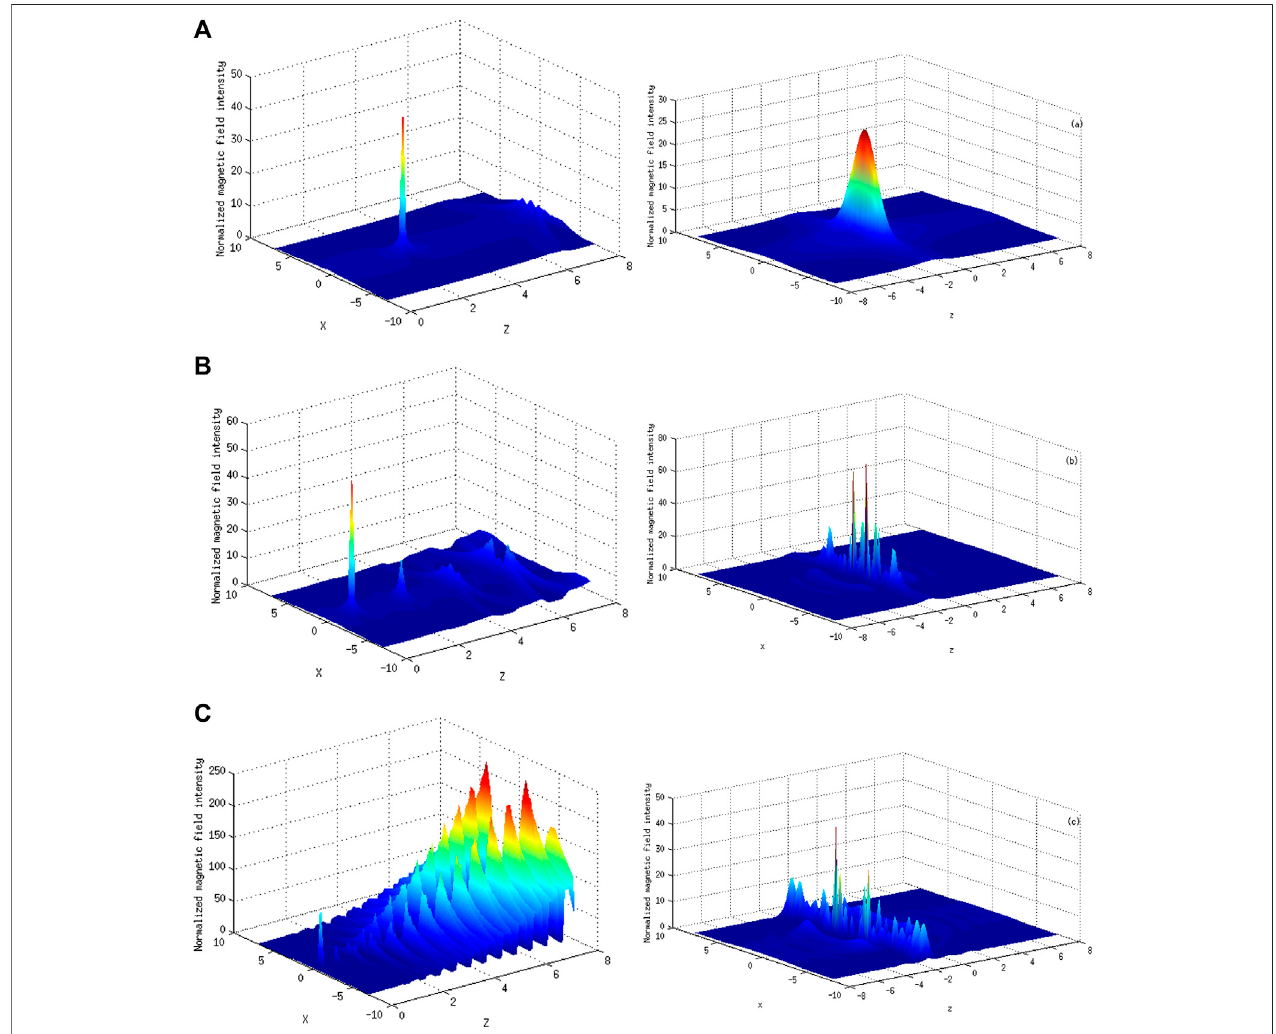
FIGURE 5 | Normalized magnetic fi eld intensity distribution (| B 2 y | / B 2 n ) of the wave from the (1) Simpli fi ed model and (2) Numerical simulation in a normalized x – z plane(( x normalizedwith x n (cid:2) ρ s and z normalizedby z n (cid:2) 2/ k 0 z ),at (A) t=9, (B) t=11,and (C) t=12. “ Reproducedfrom[(SharmaandGaur,2014), PhysicsofPlasmas , 21 , 042,302, http://dx.doi.org/10.1063/1.4870500], with the permission of AIP Publishing.